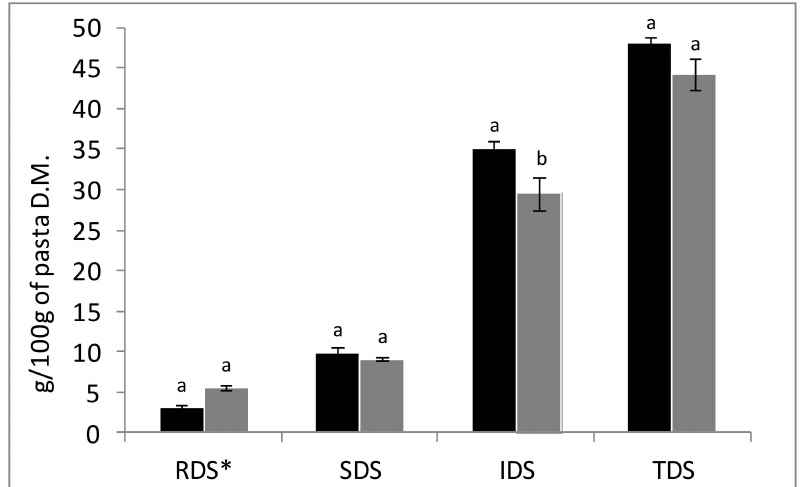
Figure 1. Results of in vitro digestion of pasta samples. RDS, rapidly digestible starch; SDS, slowly digestible starch; IDS, inaccessible digestible starch; TDS, total digestible starch. Black bars, CP and grey bars, SP. Di ff erent letters (a, b) for the same starch fraction denote a statistically significant di ff erence between samples at p ≤